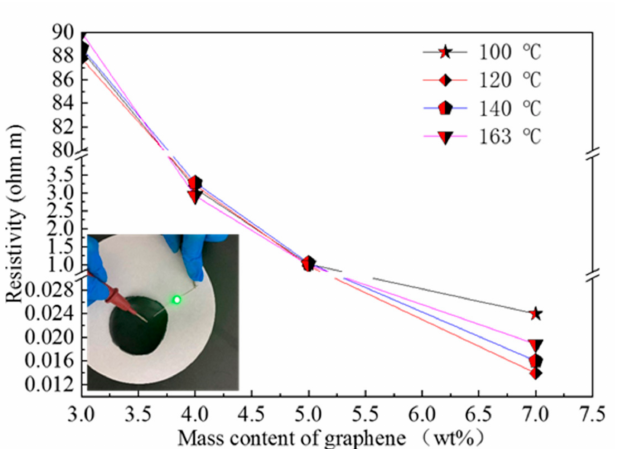
Figure 2. Relationship between the resistivity of the conductive films composed of four different melting points of TPU and the graphene mass content, respectively. The insert is photo of light emitting diode device on the G-TPU conductive film.